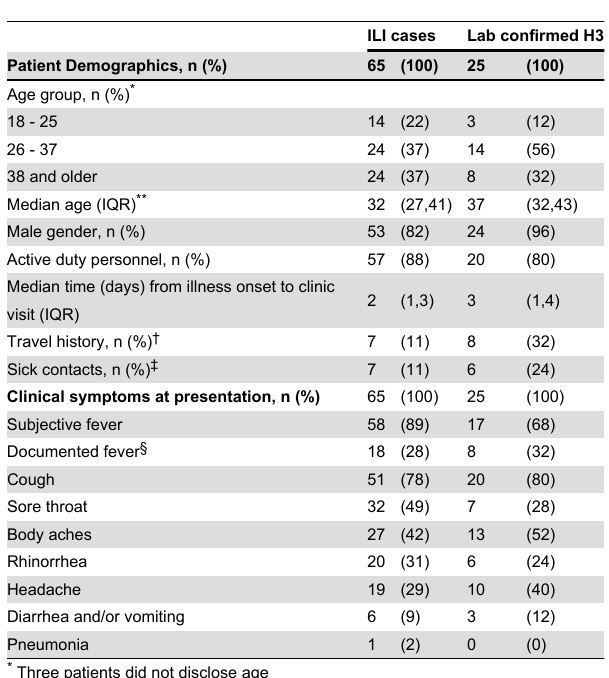
Table 2. Patient characteristics for influenza-like illness (ILI) and laboratory confirmed H3